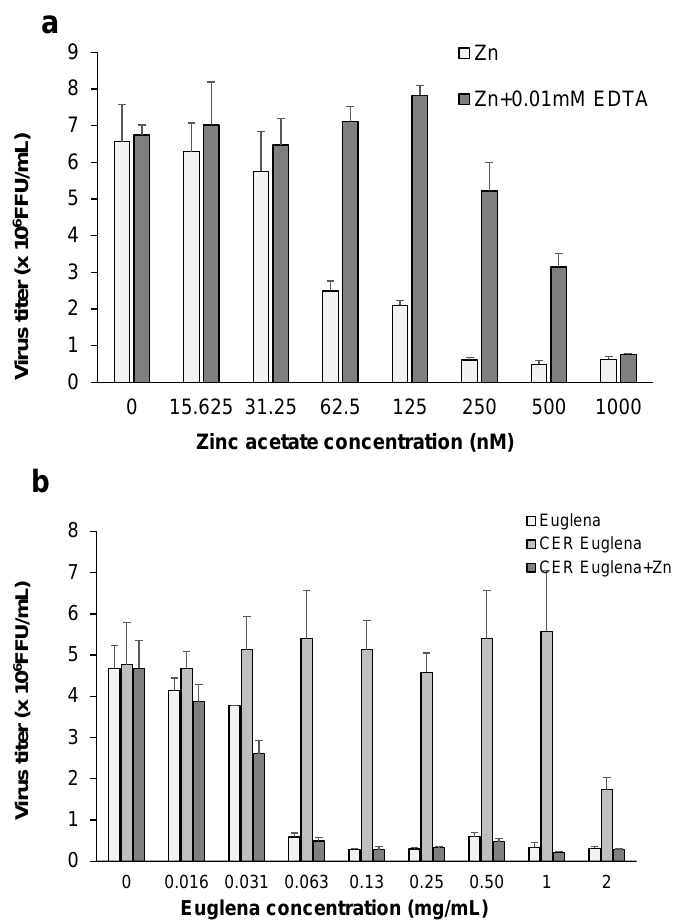
Figure 6. Involvement of zinc in Euglena extract. Madin–Darby canine kidney (MDCK) cells were cultured 24 h before virus infection with ( a ) zinc acetate, ( b ) Euglena extract, CER-treated Euglena extract, and CER-treated Euglena extract + zinc acetate. Cells were infected with virus after exchanging medium, and then the virus titer was determined. The respective zinc concentrations are shown in Table 2. Error bars indicate standard deviations ( n = 3). CER: cation exchange resin, FFU: focus-forming units.